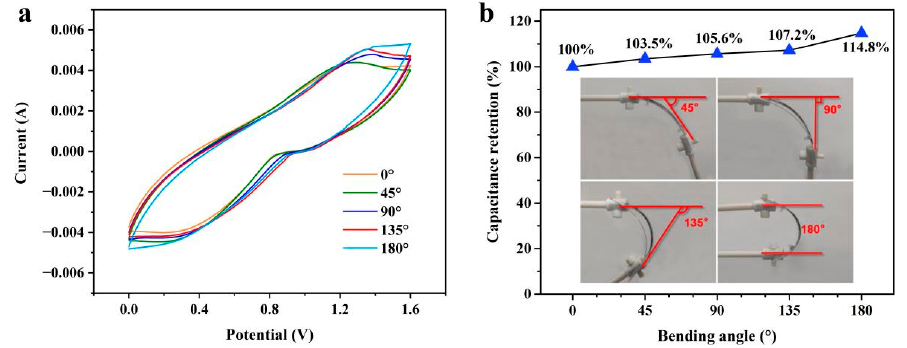
Figure 9. ( a ) CV curves of the WASC device under di ff erent bending angles at the scan rate of 40 mV s − 1 ; ( b ) the capacitance of the device at di ff erent bending